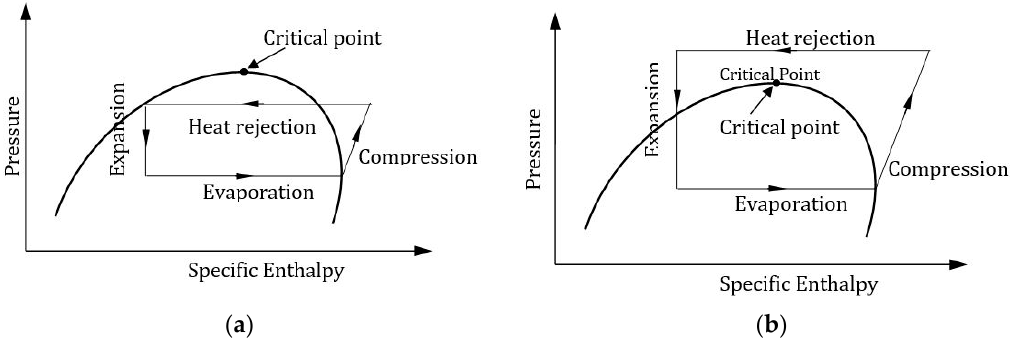
Figure 1. P–h diagrams: ( a ) Subcritical cycle and ( b ) Transcritical cycle. Reproduced with permission from [12]. Elsevier, 2011.